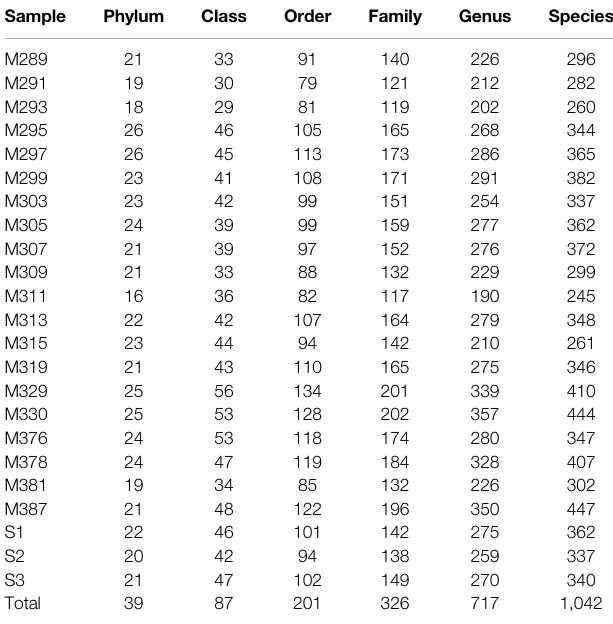
TABLE 2 | Taxonomy classi fi es the distribution table of each sample in the Linxia Basin. Sample